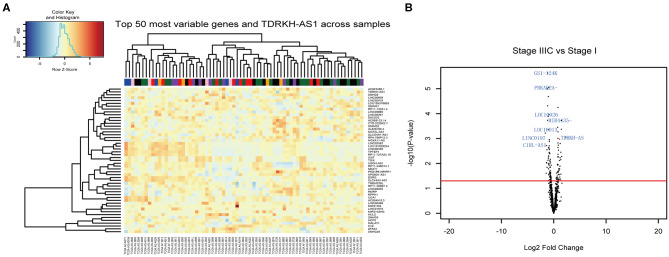
TDRKH-AS1 is a long non-coding antisense RNA that is upregulated in colorectal cancer (CRC). (A) The 71 CRC tissue samples in The Cancer Genome Atlas (TCGA) database were analyzed and sorted into stage I (black), stage II (blue), stage IIA (green), stage III (orange), stage IIB (purple), stage IIIC (pink), and stage IV (red). (B) The long non-coding RNAs (lncRNAs) with high abundance were verified in the CRC TCGA database.